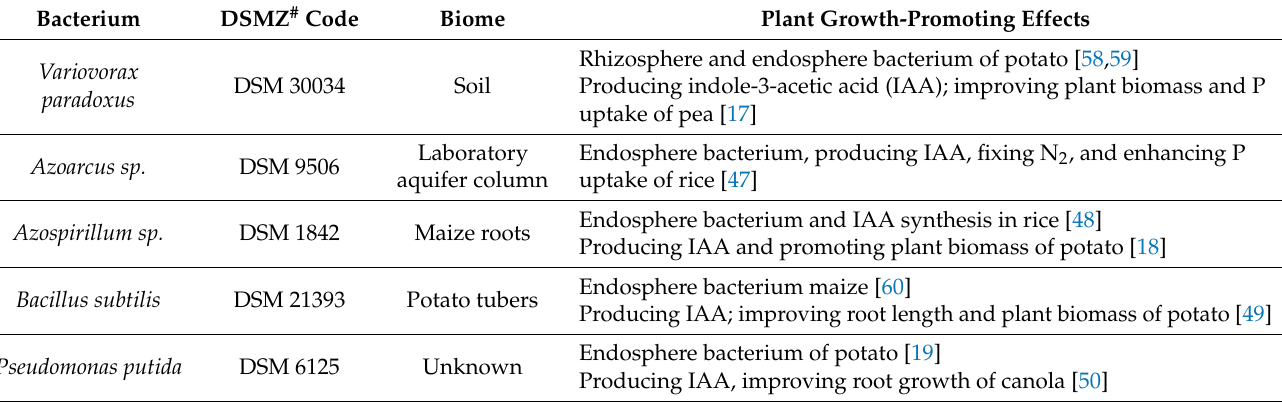
Table 3. List of the bacteria strains, biome, and their growth-promoting